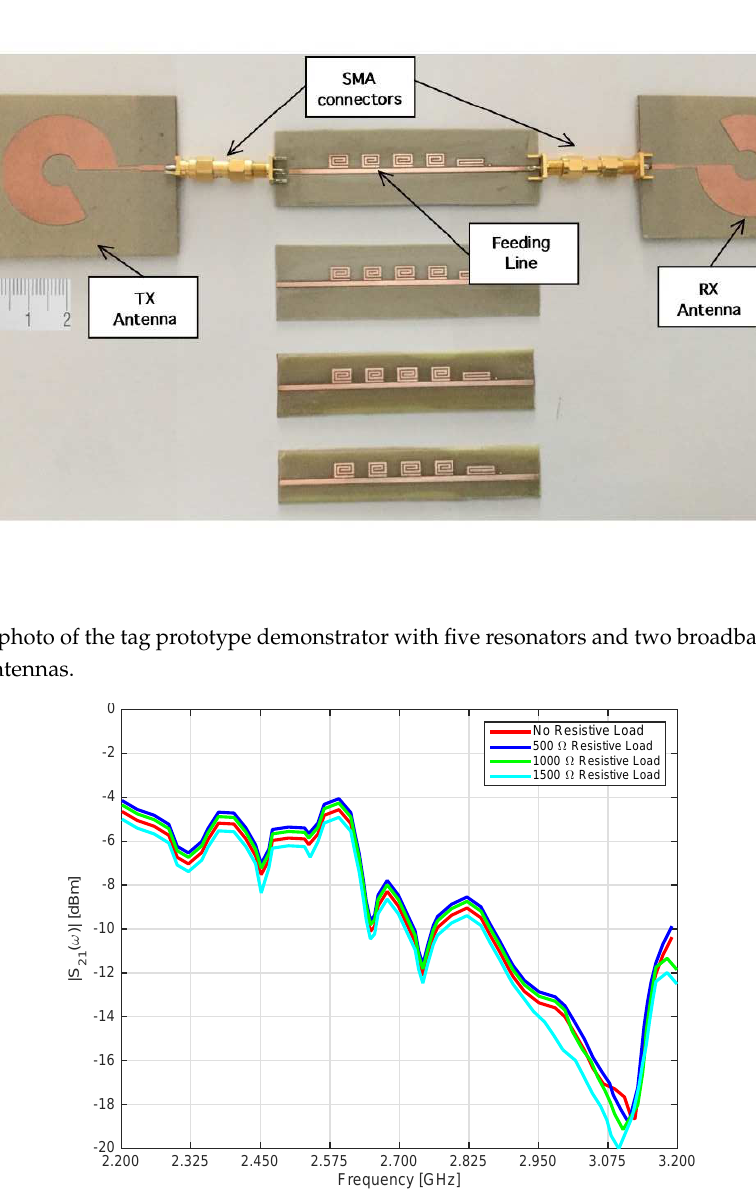
Figure 10. The effects of resistive loads on the resonator